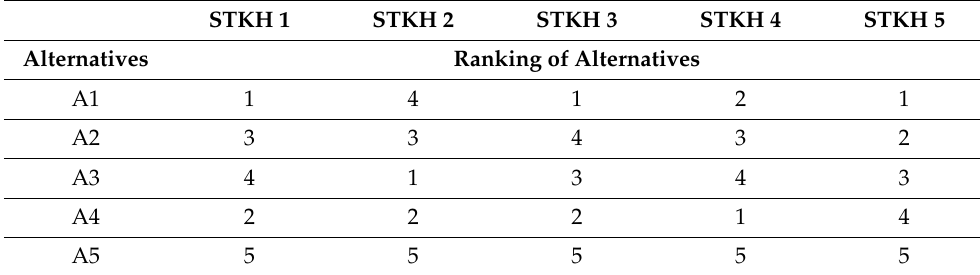
Table 7. Ranking of